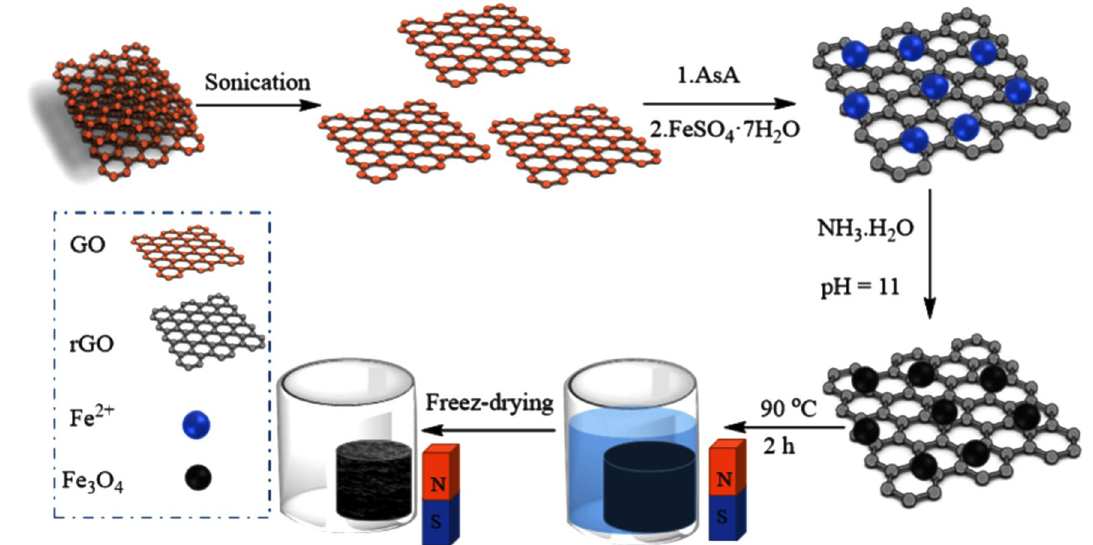
Figure 2. Schematic diagram of the preparation of the 3D-rGO/Fe 3 O 4 nanostructures.